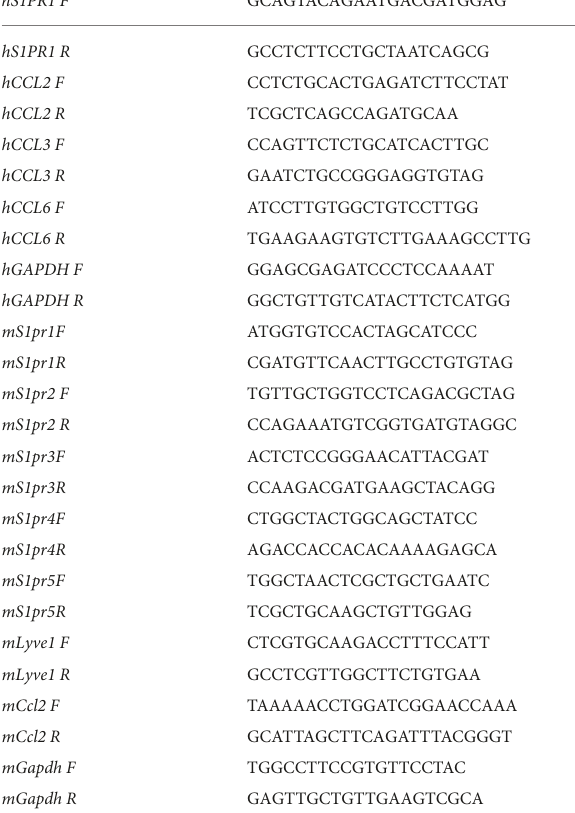
TABLE 1 The primer list for real-time quantitative polymerase chain reaction analysis of mRNA expression